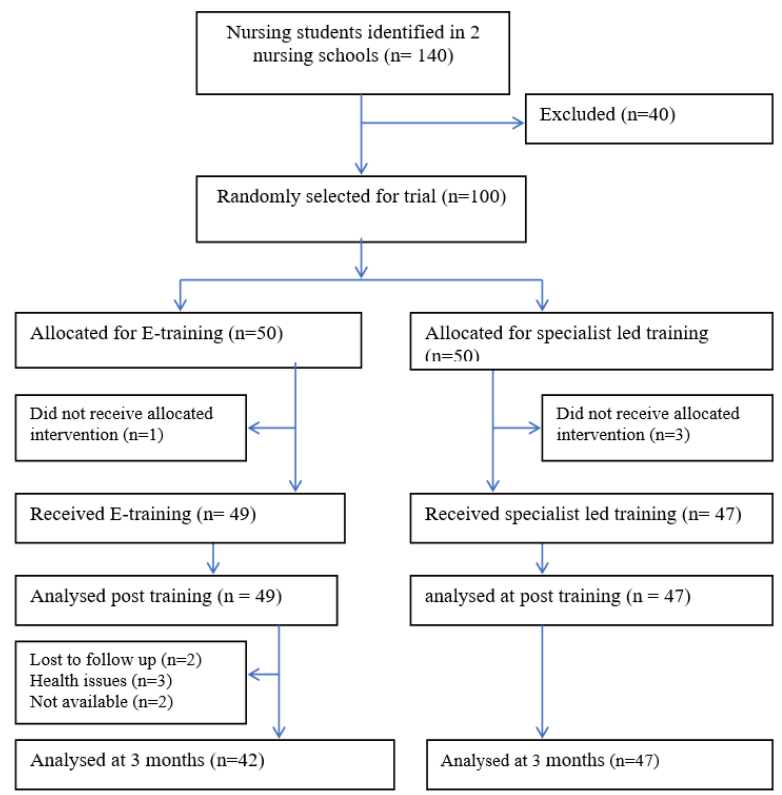
Figure 1. (CONSORT flow diagram).